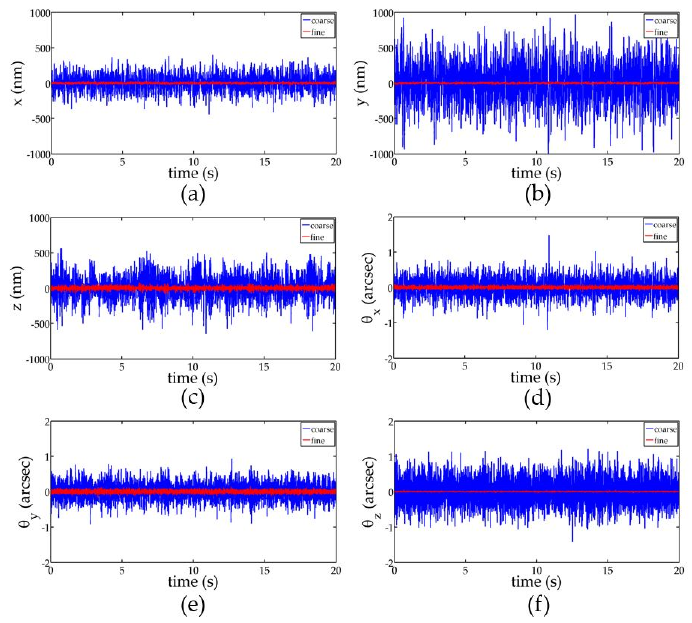
Figure 11. The evaluated in-position stability data of the dual servo stage: ( a ) x direction, ( b ) y direction, ( c ) z direction, ( d ) θ x direction, ( e ) θ y direction, ( f ) θ z direction. Table 7. The evaluated in-position stability of the dual servo stage with RMS